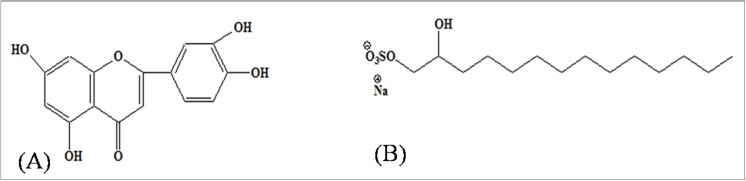
Chemical structure of the isolated compound(s) Luteolin (A) and Tetradecanediol (B) isolated from the antiviral fraction of Pedilanthus tithymaloides leave extracts.